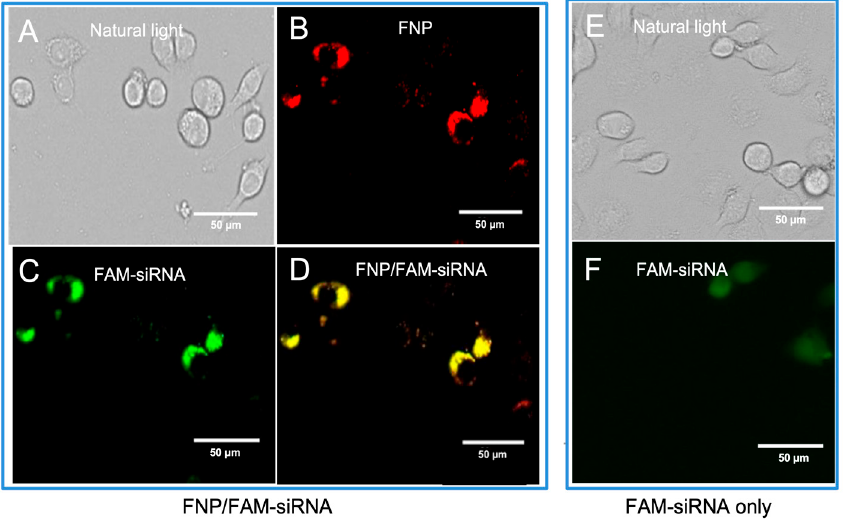
Figure 1. Fluorescence images of FNP–siRNA complexes in cells at 24 h after incubation (0.05 μ M FNP, 100 µ M DNA, N/P = 2:1, red: FNP, green: FAM fluorescence). For FNP/FAM-siRNA delivery group: ( A ) Bright-field channel. ( B ) Red fluorescence channel showing FNP. ( C ) Green fluorescence channel showing FAM-siRNA. ( D ) Fluorescence images of FNP-siRNA complexes (( B , C ) merged). For the control group, FAM-siRNA only: ( E ) Bright-field channel. ( F ) Green fluorescence channel showing FAM ‐ siRNA.